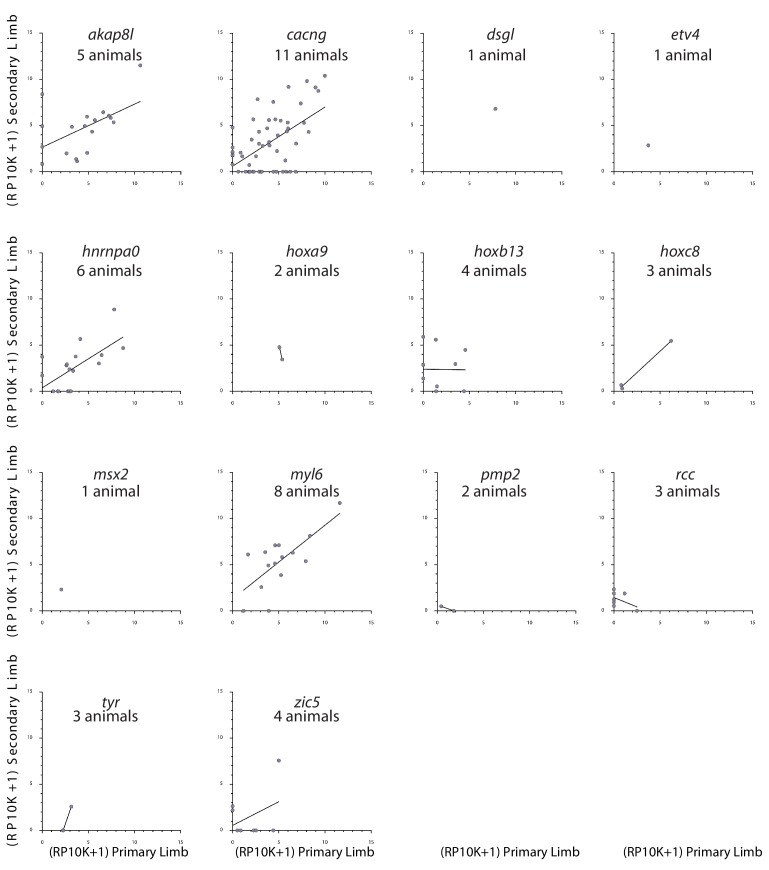
Linear regression plot of the log2(RP10K) score for all alleles in primary and secondary of each targeted gene for which no significant deviation was detected from that of control alleles (akap8l, p=0.069; cacng, p=0.166; hnrnpa0, p=0.371; hoxa9, p=0.637; hoxb13, p=0.053; myl6, p=0.850; pmp2, p=0.624; rcc, p=0.176; tyr, p=0.532,; zic5, p=0.480; ANCOVA).Best-fit lines are added for genes for which more than one allele was detected. Numbers of animals in which mutations were detected are listed under each gene name.